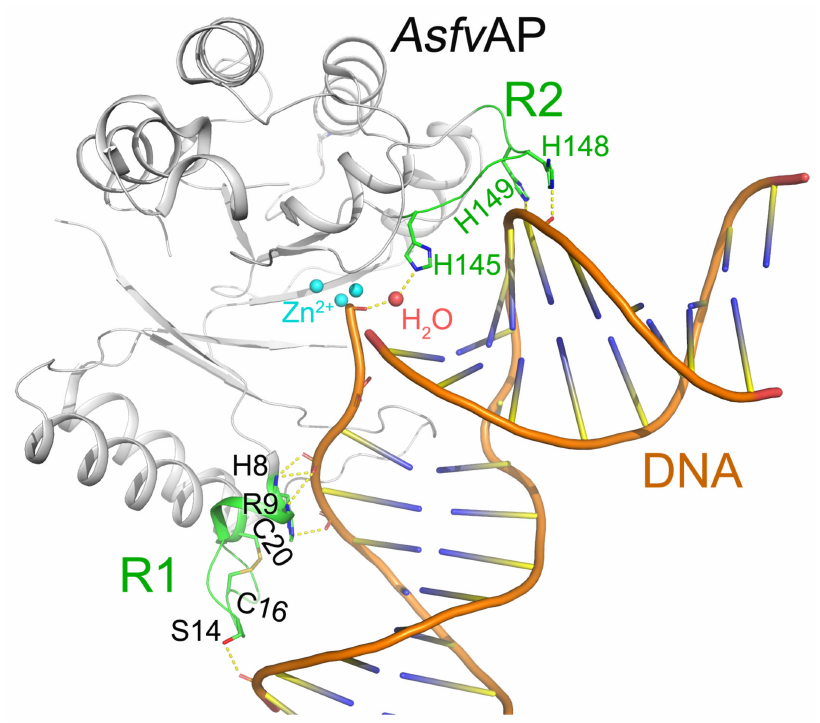
Figure 2. Detailed interactions between DNA and Asfv AP (pdb: 6KI3) [19]. Regions R1 and R2 are colored green. The interacting residues and the disulfide bond Cys16-Cys20 of R1 are highlighted by